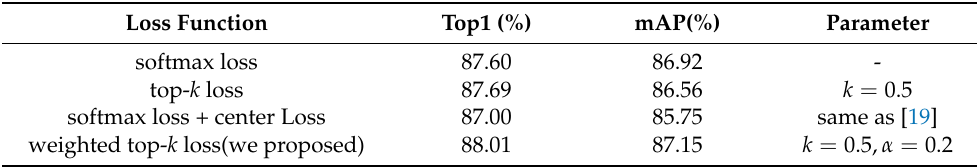
Table 8. Mineral recognition results using different loss functions based on fused features. Loss